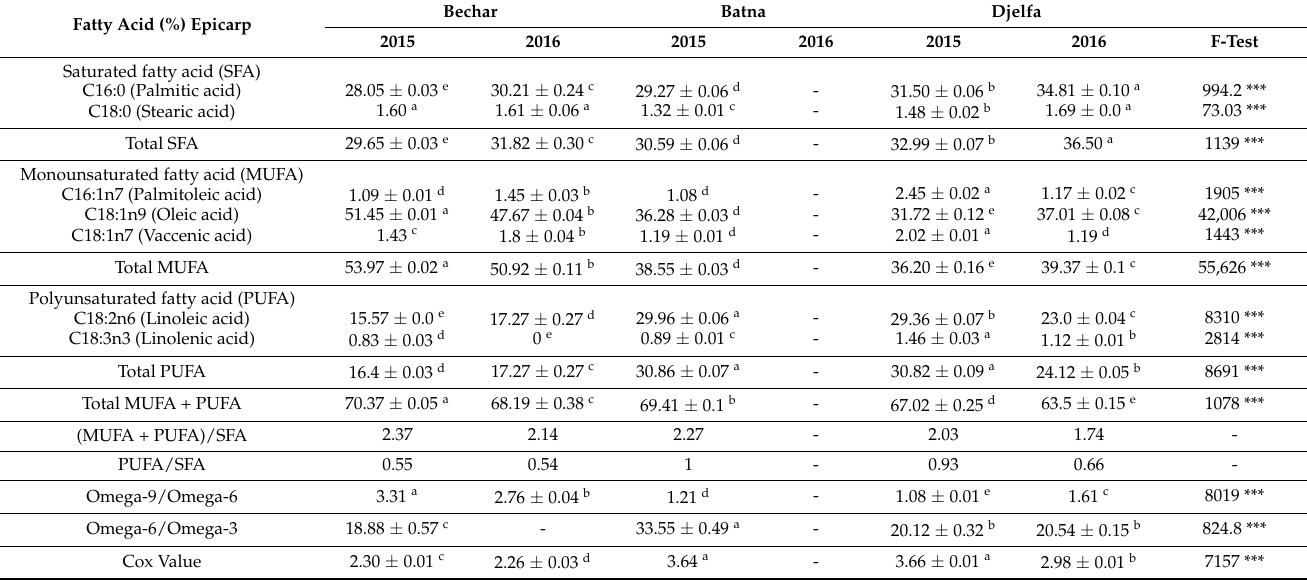
Table 4. Fatty Acid (%) Composition of the Epicarp of Atlas Pistachio in Three Geographic Zones in Algeria for Two Years